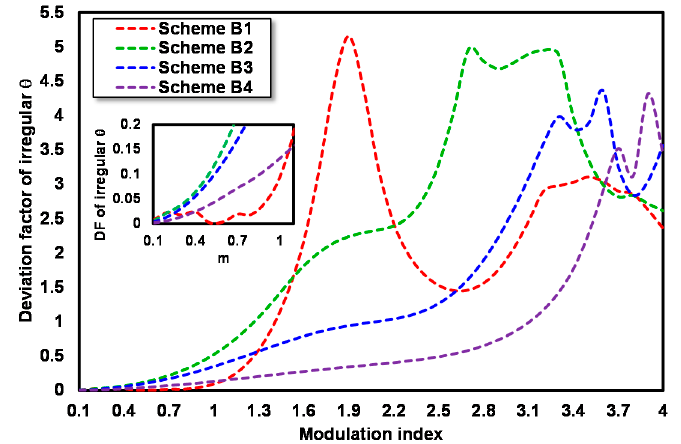
Figure 8. DF value for each irregular θ at 0.1 ≤ m ≤ 4 of schemes B1, B2, B3 and B4.